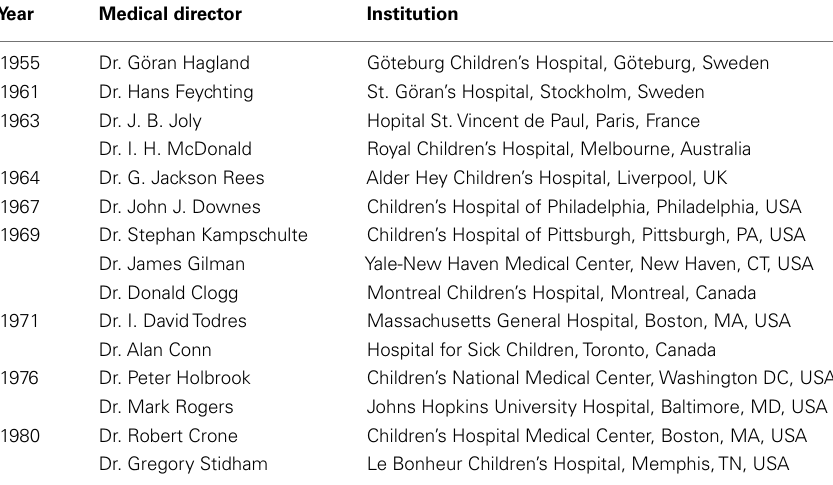
Table 1 | Early history of pediatric ICUs